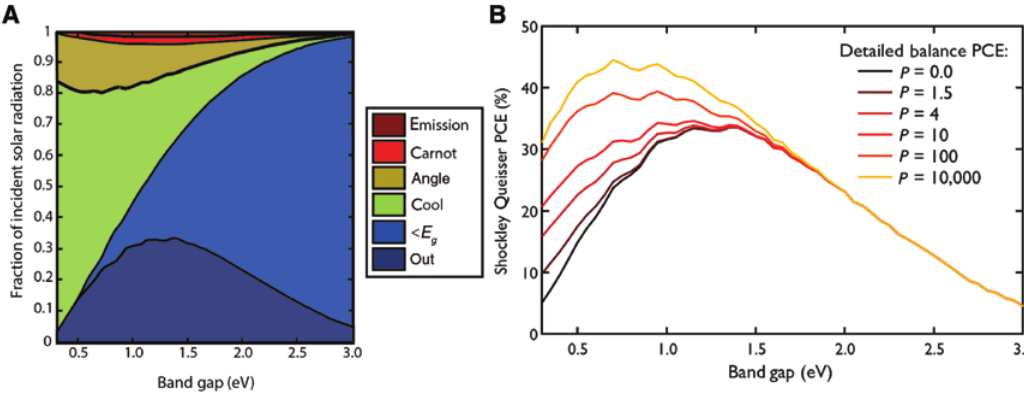
Figure 1: Shockley-Queisser limit: loss processes and potential efficiency enhancement by MEG. (A) Breakdown of the different loss processes leading to the band gap-dependent Shockley-Queisser limit for single junction solar cells (out, dark blue). < E (light blue) and cool (green) represent the energy losses due to incomplete absorption and rapid cooling of hot carriers, g respectively, angle (orange) and emission (dark red) are entropic losses associated with angle restriction and incomplete light trapping, respectively, and Carnot (light red) expresses the thermodynamic efficiency limit. (B) Theoretical enhancement of the Shockley-Queisser limit for single junction solar cells due to MEG where the parameter P relates the rates for MEG ( k through the expression P = k / k . Part B has been adapted from MEG therm